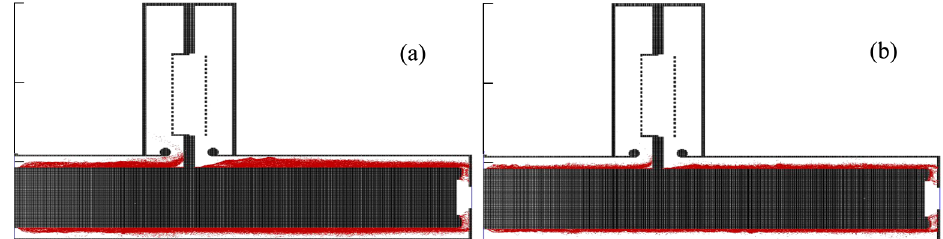
FIG. 14. Electron phase space in the YZ plane at different moments. Part (a) represents t ¼ 71 ns , a moment close to inflexion of curves in Fig. 12. As can be seen, although a fraction of electrons strike onto the support rod, electrons are insulated from anode nearly everywhere. Part (b) represents t ¼ 108 ns , at which current reaches almost the maximum, magnetic insulation is established very well.